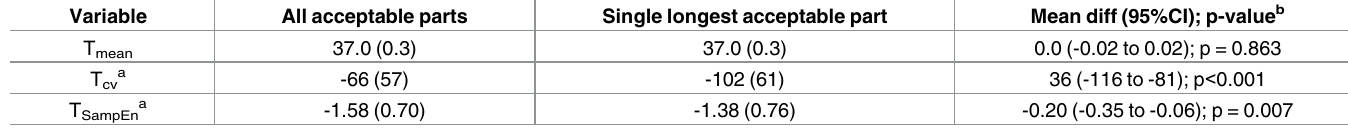
Table 5. Sensitivity analysis related to amount and fragmentation of